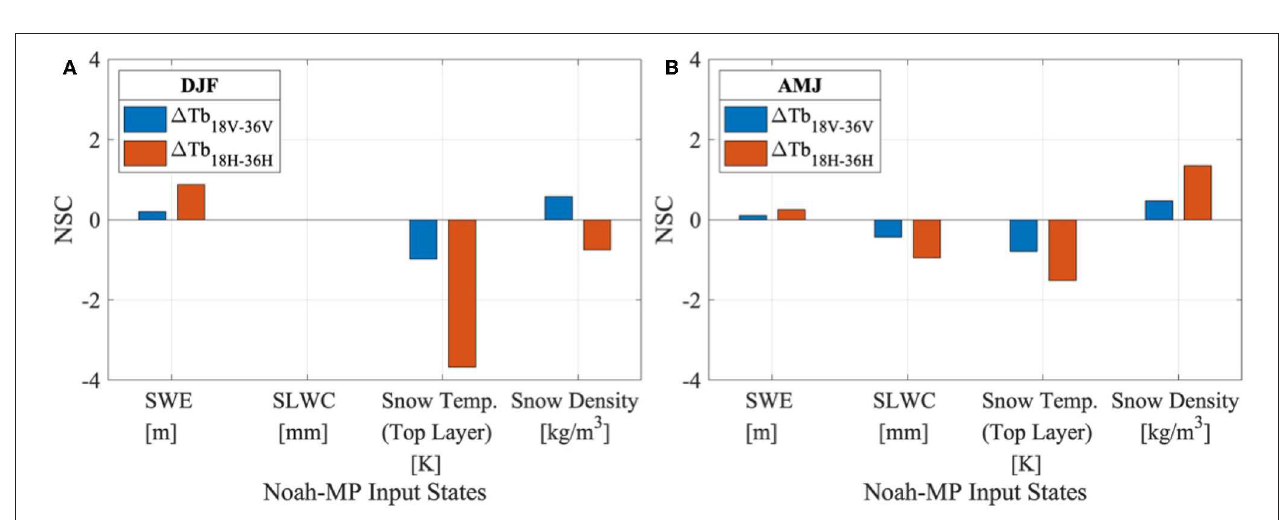
FIGURE 9 | Relative importance of geophysical variables (via Noah-MP) for SVM-based predictions of 1 Tb 18.7–36.5 averaged over the (A) snow accumulation (dry) period [Dec, Jan, Feb] and (B) snow ablation (wet) period [Apr, May, Jun] at a point location in HMA (37.8750 ◦ N, 75.3750 ◦ E).